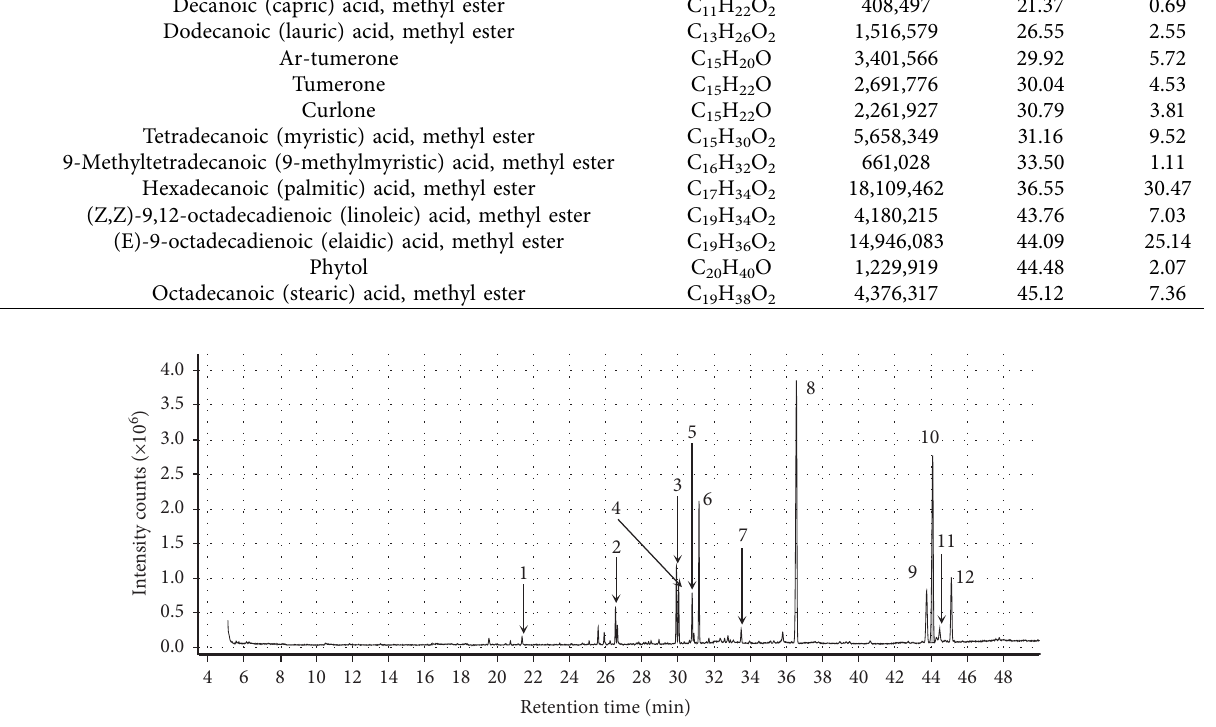
Figure 1: GC-MS analysis of A. elegans leaf gel extract. Table 5: Physical inspection of hair washing formulations of A. elegans